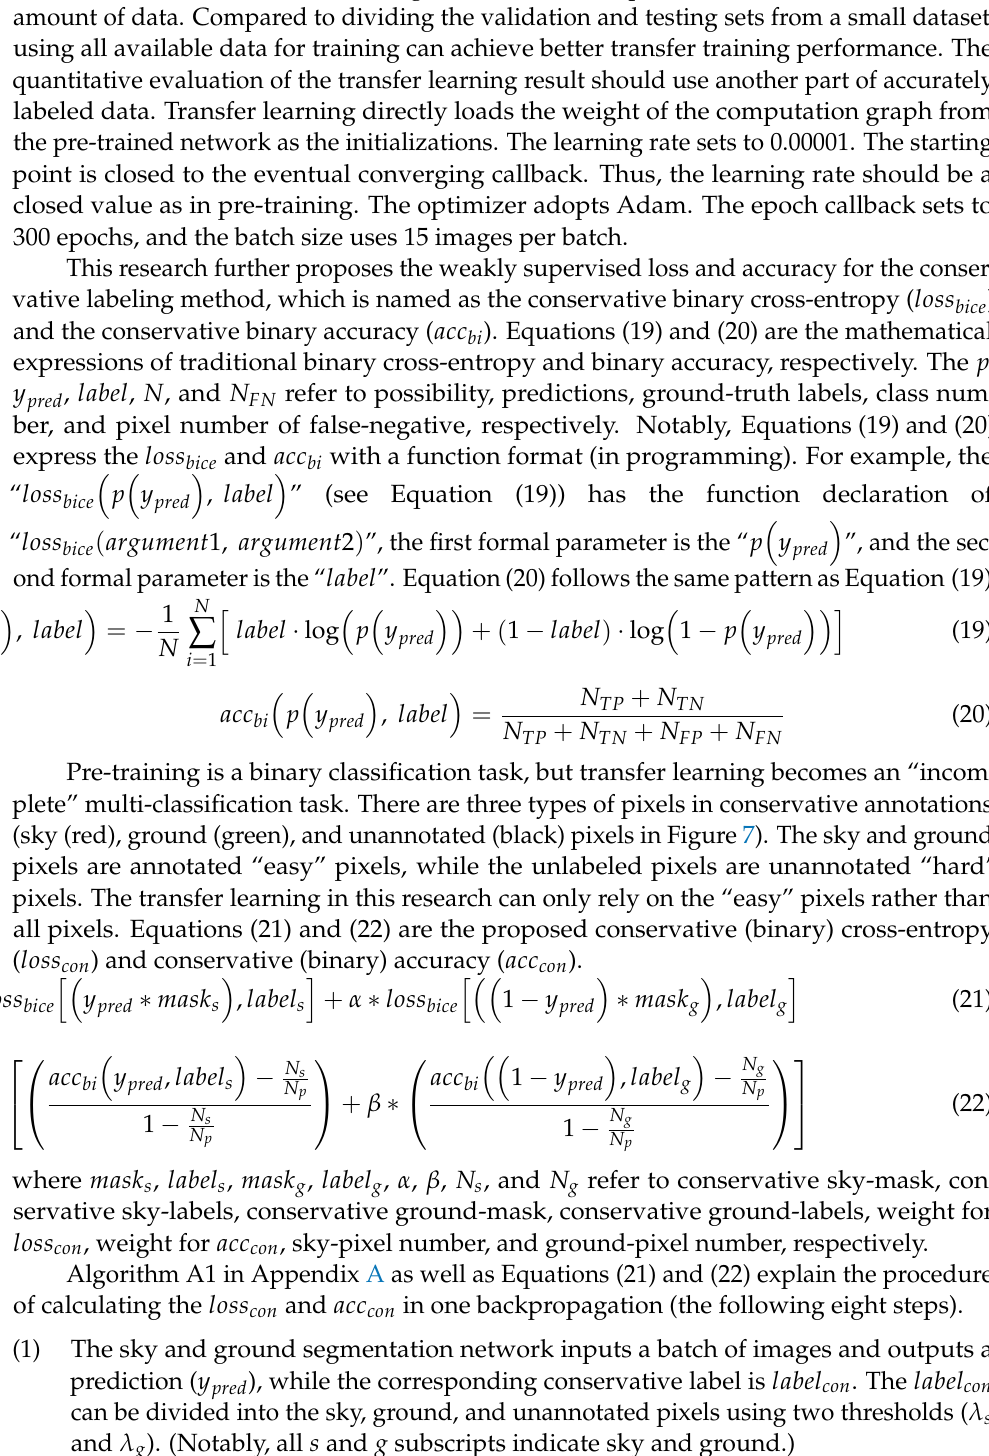
Algorithm A1 in Appendix A as well as Equations (21) and (22) explain the procedure of calculating the loss con and acc con in one backpropagation (the following eight